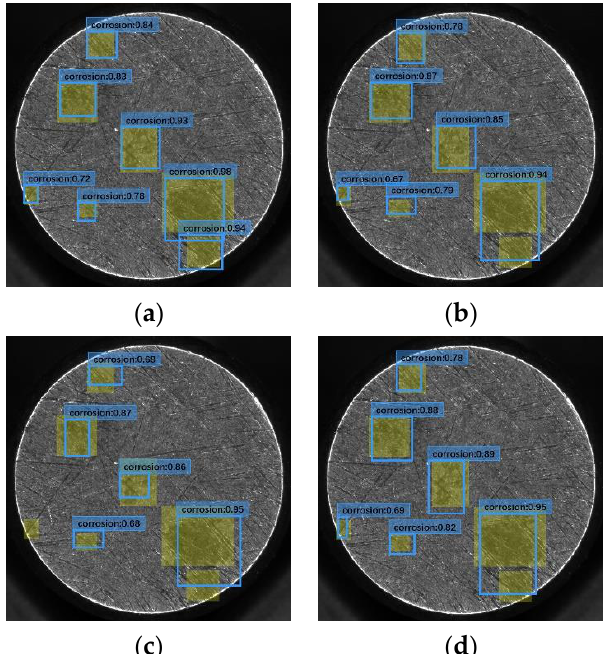
Figure 11. Detection results under different base networks: ( a ) Resnet-50; ( b ) VGG-19; ( c ) MobileNet; and ( d ) our CNN model.